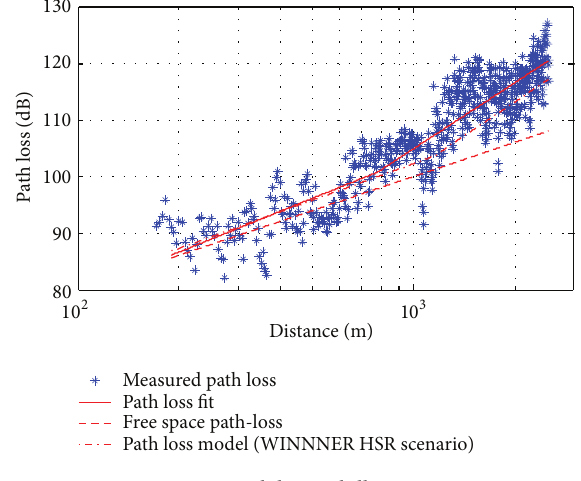
Figure 3: Path loss in hilly